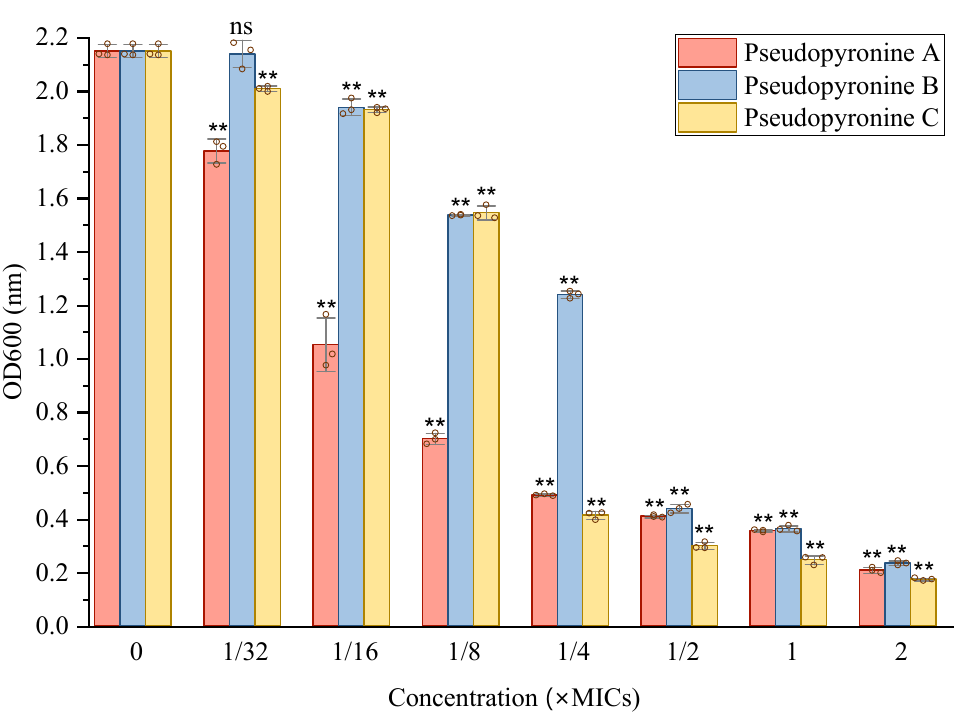
Figure 3. Effects of sub-MIC concentrations of pseudopyronine A, B and C on biofilm formation of S. aureus , as determined by crystal violet assay at different sub-MIC concentrations (1/32 × to 2 × MIC) Data are presented as mean ± SD, n = 3, ** p < 0.01, ns p > 0.05 (not statistically significant), compared to the control group. Individual data points are shown as hollow circles, for reference.